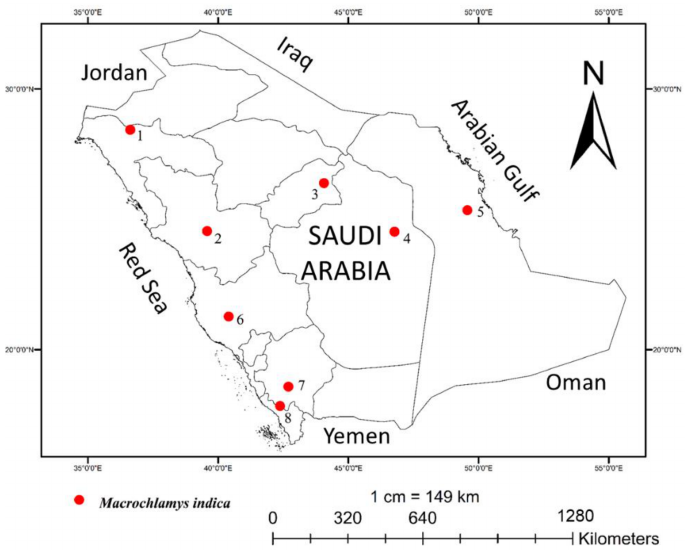
Figure 2. Distribution map of Macrochlamys indica in Saudi Arabia. 1. Tabouk, 2. Al-Madinah, 3. Al-Qassim, 4. Riyadh, 5. Al-Ahsaa, 6. Taif, 7. Abha, and 8. Jazan.